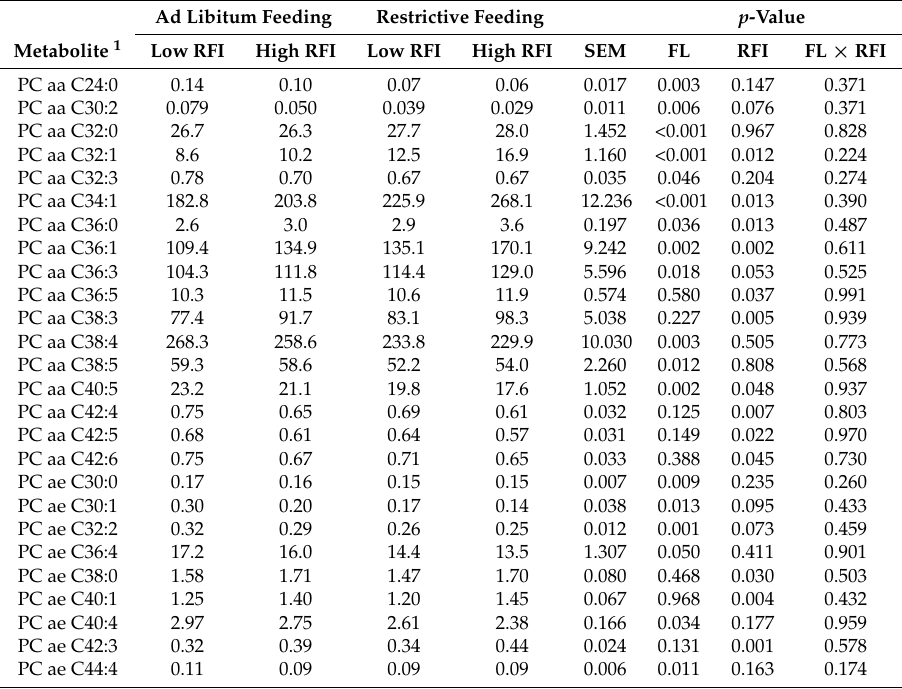
Table 3. Selected serum diacyl- and acyl-alkyl-glycerophosphatidylcholines ( µ mol/L) in low and high residual feed intake (RFI) broiler chickens fed either ad libitum or restrictively. Ad Libitum Feeding Restrictive Feeding p -Value